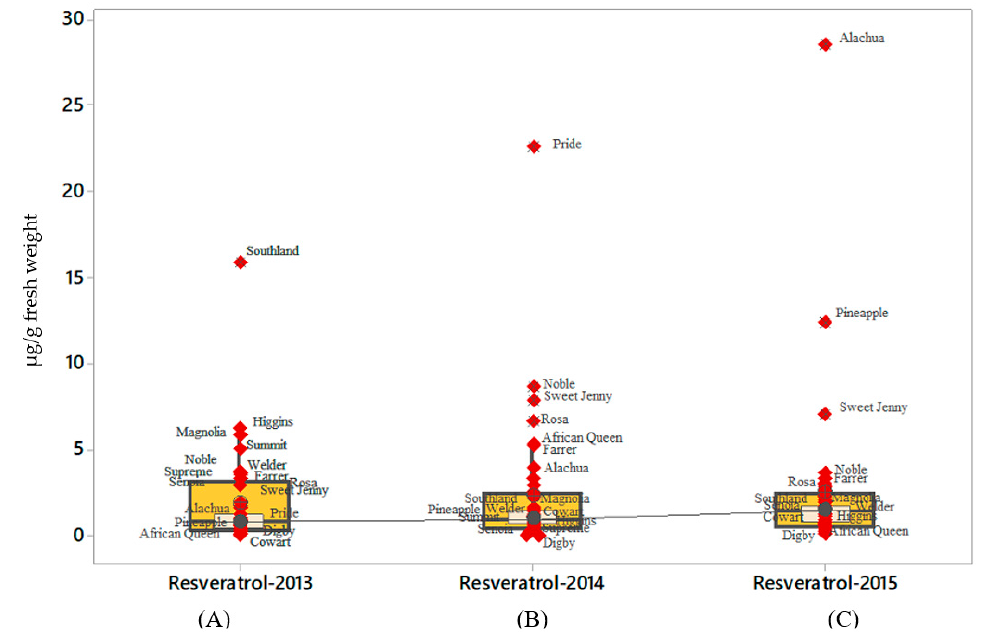
Figure 3. Total t -resveratrol content accumulated among different muscadine cultivars. The total Figure 3. Total t ‐ resveratrol content accumulated among different muscadine cultivars. The total t ‐